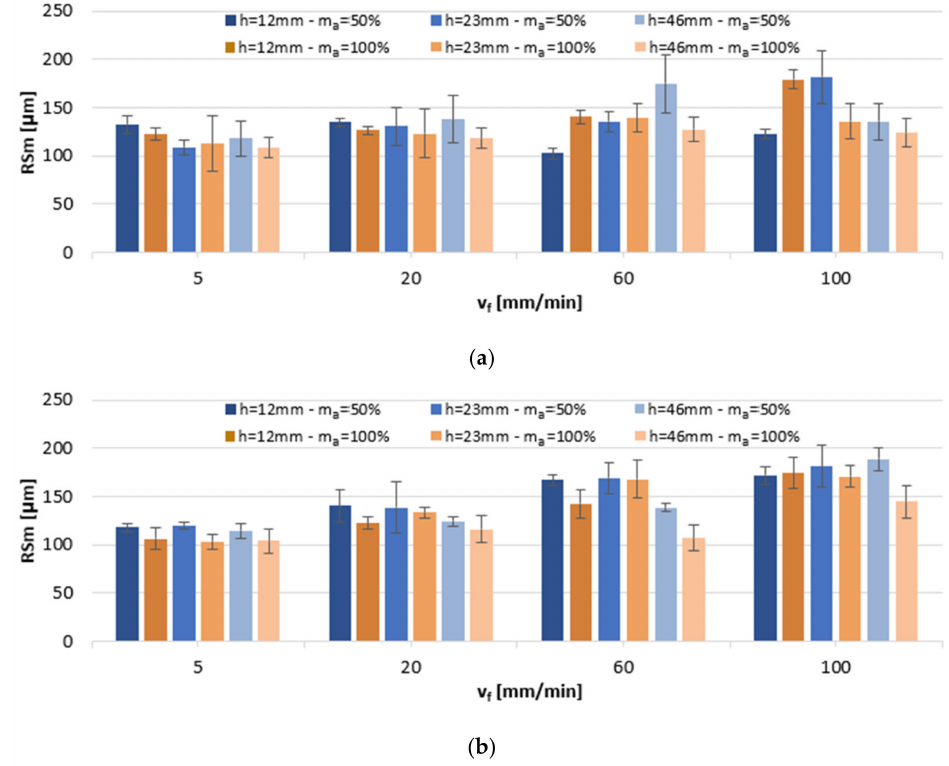
Figure 4. The impact of jet feed rate v f , sample height h, and abrasive flow rate m a on RSm of post-machined alloys: ( a ) AlSi10Mg and ( b ) AlSi21CuNi.